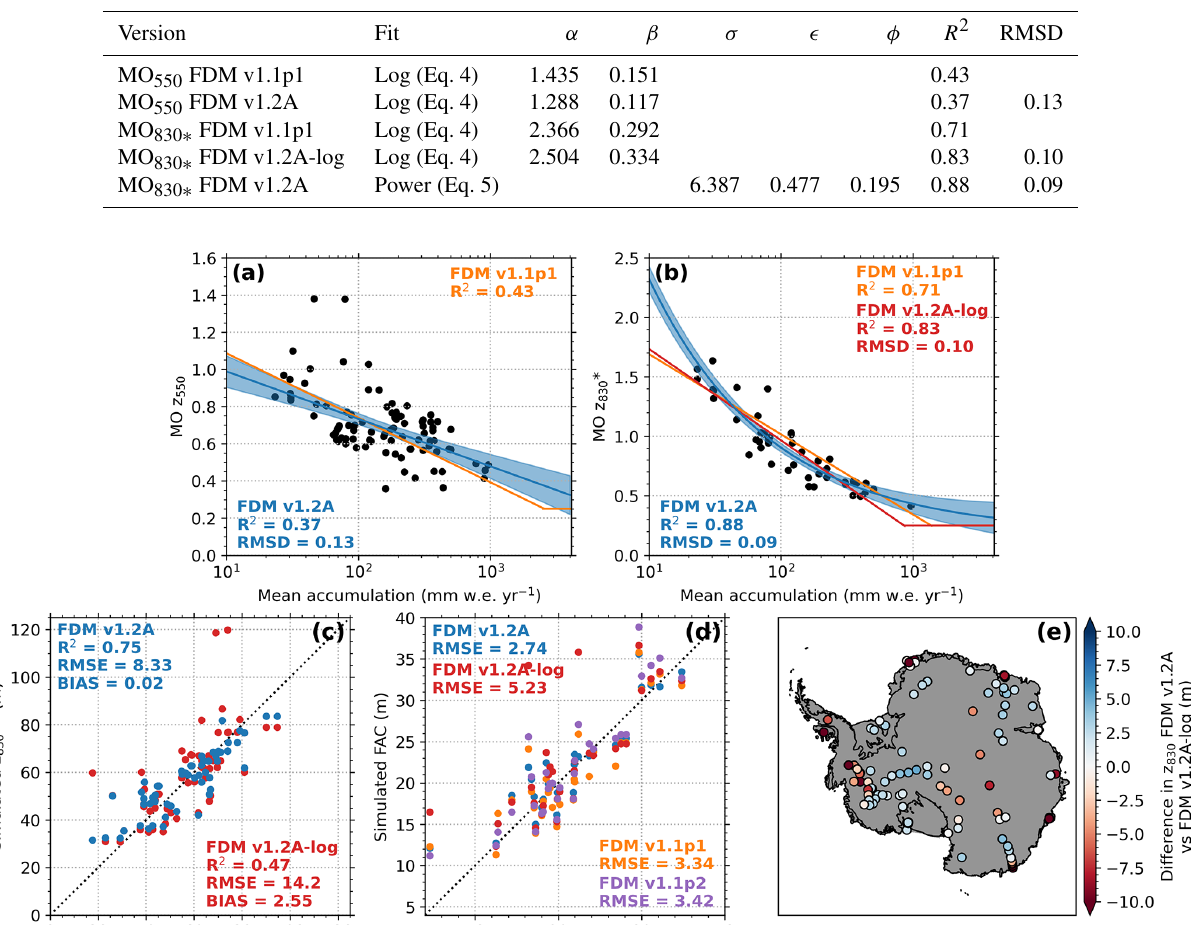
Table 4. Fit coefficients and statistics of the MO fits (Eqs. 4 and 5). The fit coefficients and statistics of FDM v1.1p1 are taken from Ligtenberg et al. (2011). Please note that R 2 for v1.1p1 applies to the calibration dataset used in that study. The FDM v1.2A-log uses the settings of FDM v1.2A; only Eq. (3) is optimized using a logarithmic MO 830 ∗ fit. The root mean squared deviation (RMSD) quantifies the deviation with respect to the fitted function.